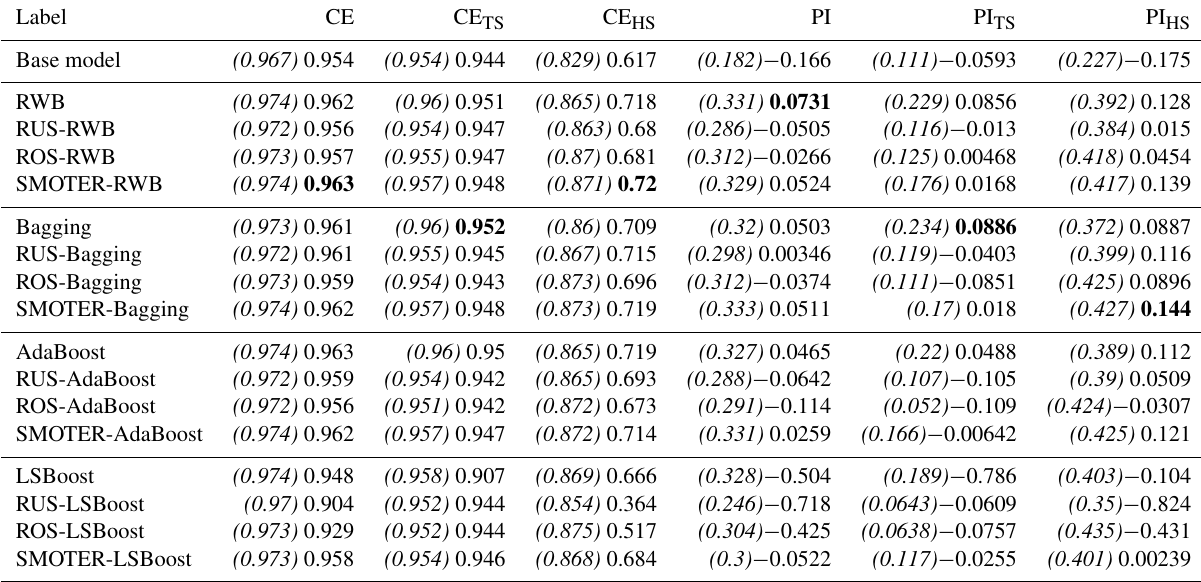
Table 5. Mean CE and PI scores for all, typical, and high stage for the Bow River ensembles; the highest scores are shown in bold, and the calibration scores are italicised and enclosed by parentheses.